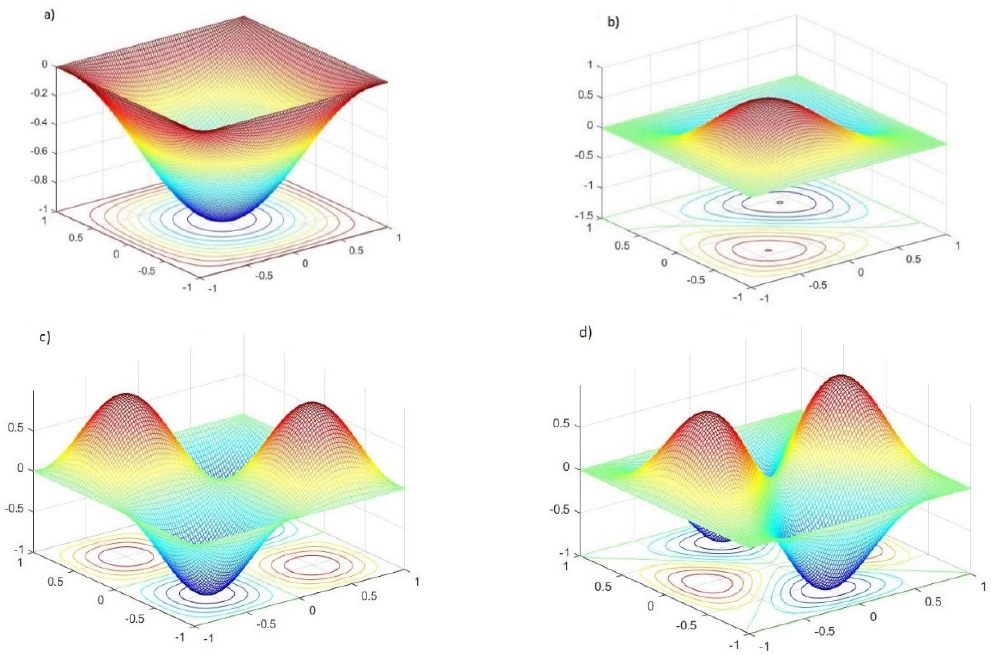
Figure 11. Vibrational modes for the SFG distribution with η = 1 and µ = 0.25: ( a ) 1st mode, ( b ) 2nd mode, ( c ) 4th mode, ( d ) 5th mode.